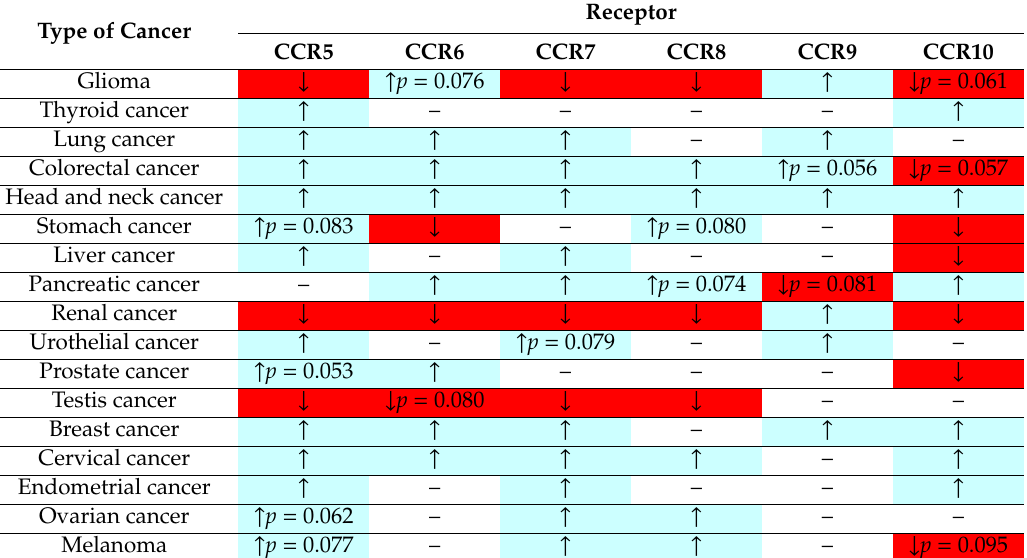
Table 2. E ff ects of increased expression of individual CC chemokine receptors discussed in this review on the prognosis of patients with various cancers according to “The Human Protein Atlas” (https: // www.proteinatlas.org / ) [7,8]. Type of